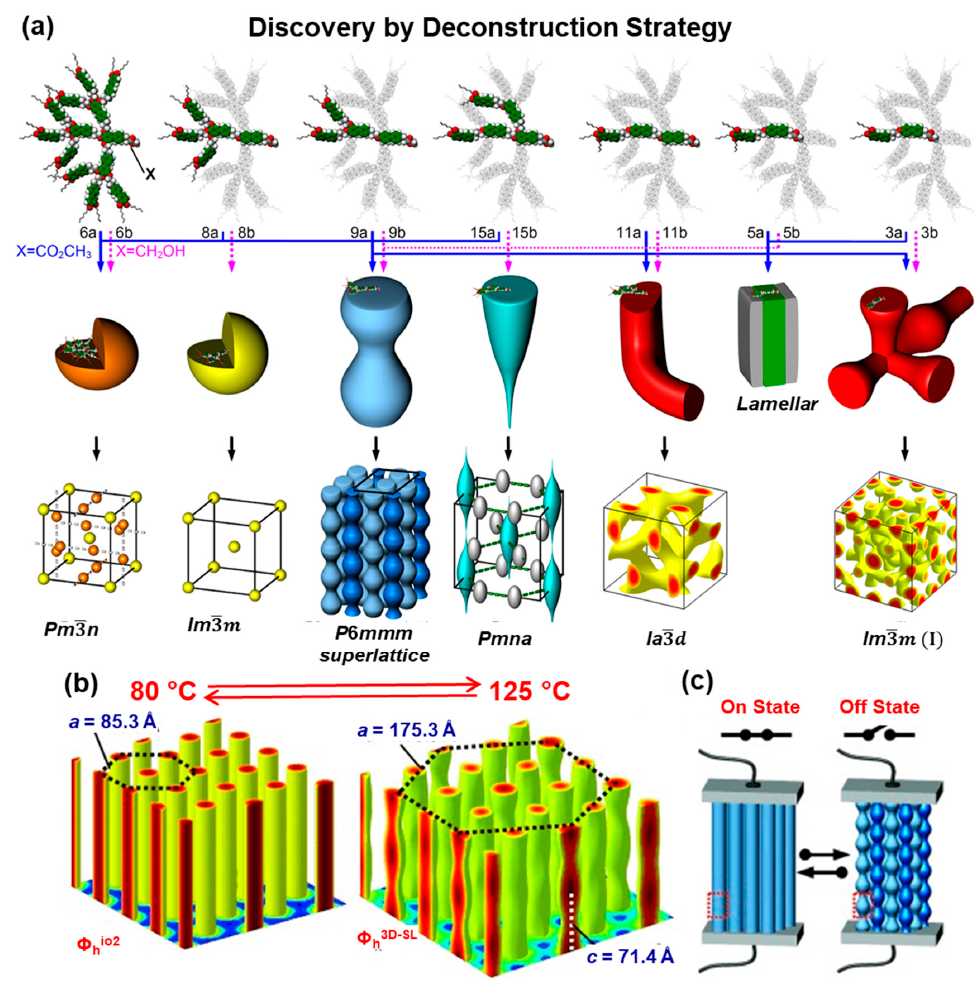
Figure 4. ( a ) A diversity of supramolecular assemblies generated from the primary structures designed by the deconstruction strategy. Novel structures from deconstructed dendritic esters (blue arrows) and alcohols (purple dotted arrows). ( b ) Reconstructed relative electron density distributions of the Φ h and Φ h3D-SL phases generated from 9b indicating the reversible transition with tem- perature. ( c ) The potential role as a supramolecular switch. [135]. The parts of the Figures were adapted from [135] and modi fi ed. Copyright © 2010 WILEY-VCH Verlag GmbH & Co. KGaA, Wein- heim.